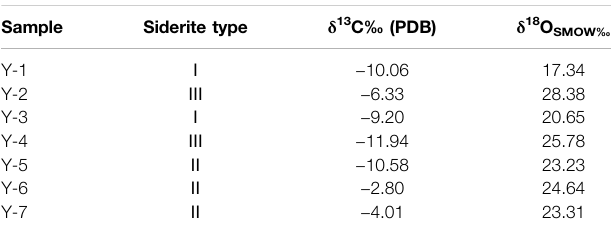
TABLE 3 | The results of carbon – oxygen